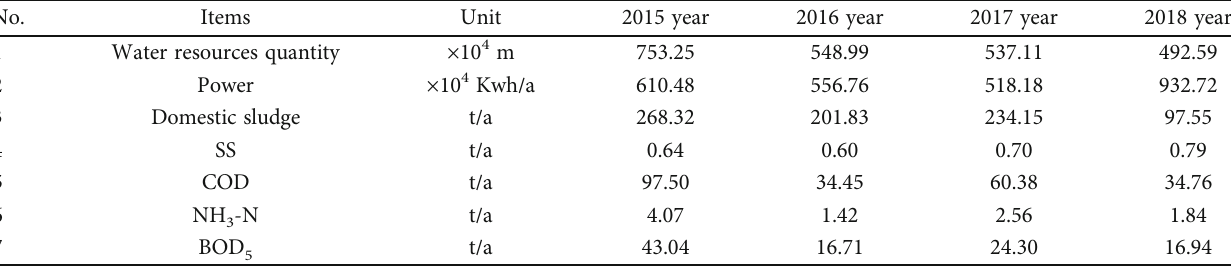
Table 5: The data of the environmental impact